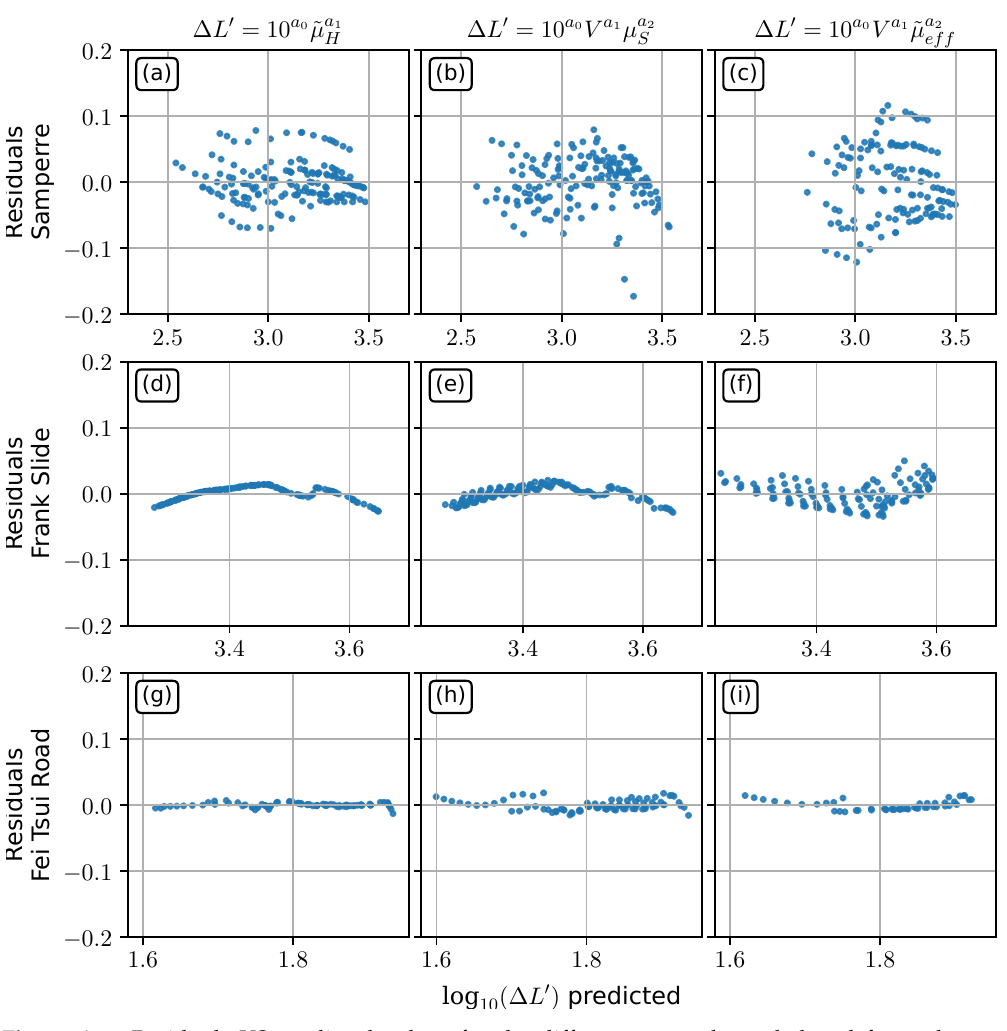
Figure A2. Residuals VS predicted values for the different power laws deduced for each case study. The axis scale is logarithmic. Each line refers to a case study, and each column to a law. ( a – c ): ∆ L (cid:48) = ∆ L (cid:48) ( ˜ µ ef f ) , ∆ L (cid:48) = f S ( V , µ S ) and ∆ L (cid:48) = f S ( V , ˜ µ ef f ) , respectively for the Samperre cliff case study. ( d – f ): ∆ L (cid:48) = ∆ L (cid:48) ( ˜ µ ef f ) , ∆ L (cid:48) = f S ( V , µ S ) and ∆ L (cid:48) = f S ( V , ˜ µ ef f ) , respectively for the Frank Slide case study. ( g – i ): ∆ L (cid:48) = ∆ L (cid:48) ( ˜ µ ef f ) , ∆ L (cid:48) = f S ( V , µ S ) and ∆ L (cid:48) = f S ( V , ˜ µ ef f ) , respectively for the Fei Tsui Road debris slide case